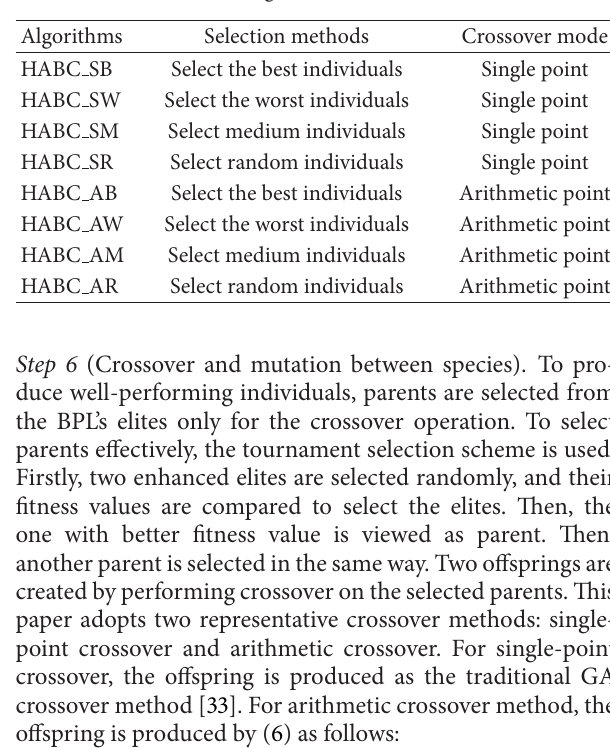
Table 1: Eight versions of